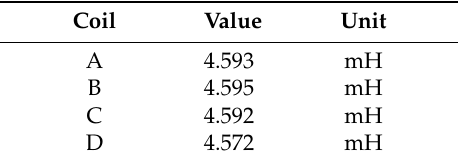
Table 3. The inductance test results for the four square coils.